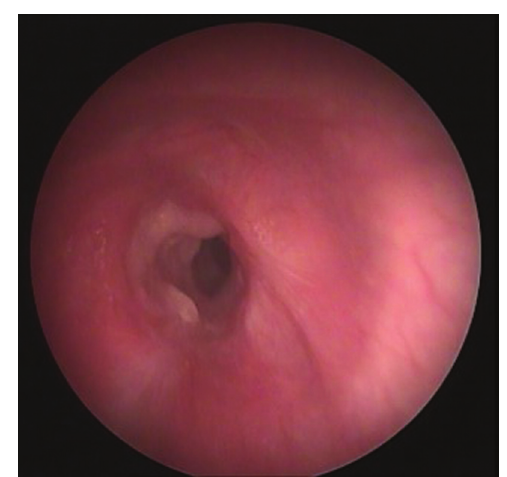
Bronchoscopic view showing grade III tracheal stenosis with partial cicatrization.